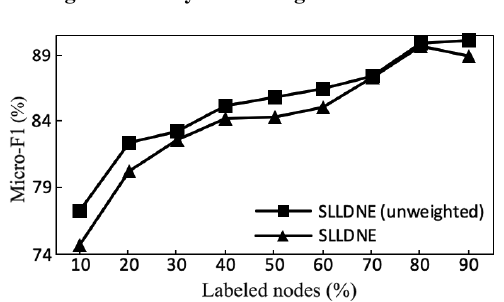
Fig. 5 Validity of the weights on CiteSeer.